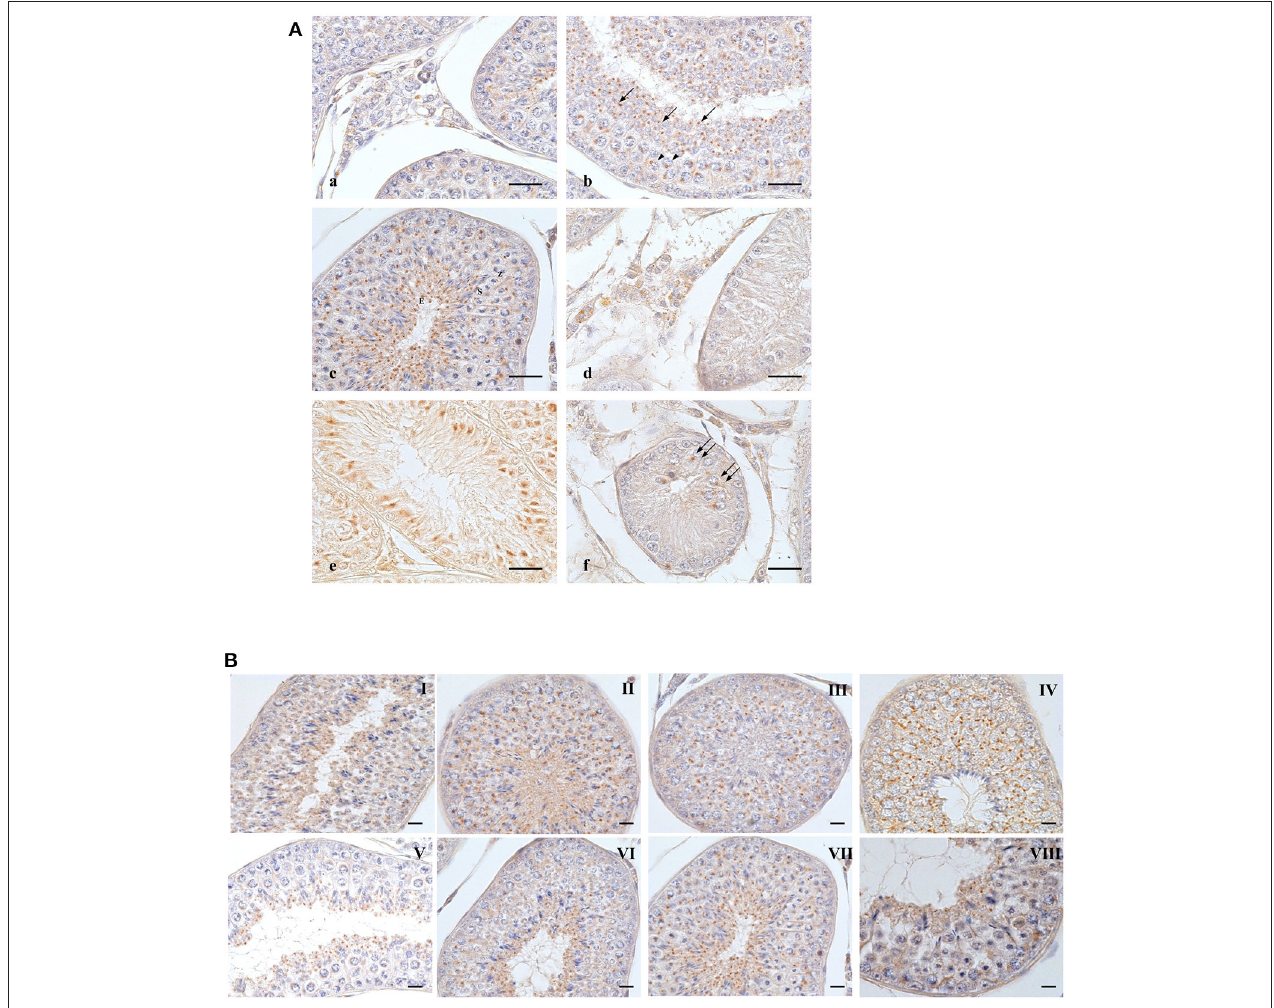
FIGURE 1 | OXB-IR in normal and cryptorchid canine testis. (A) : Group of Leydig cells labeled with fine granular stains dispersed through the cytoplasm (a); pachytenes (b, arrowheads) and zygotenes (c,Z) are stained with single round deep stain located close to the nuclear membrane; smaller roundish punctiform stain in round (b, arrows), secondary spermatocytes (c,S) and elongated spermatids (c,E). In spermatids, the immunoreactive substances are always found in the posterior portion of cytoplasm behind the nucleus, toward the luminal side of the seminiferous tubule. In cryptorchid testis, fine granular stain is distributed in the cytoplasm of Leydig cells with intermingled unstained cells (d); profound immunoreactions are observed junctional area of Sertoli cells (e). Staining in gonocytes is described as a deep round granule located in perinuclear area of cytoplasm (f). (B) : distribution OXB-IR along the germ developing cycle. Bars: 20 µ